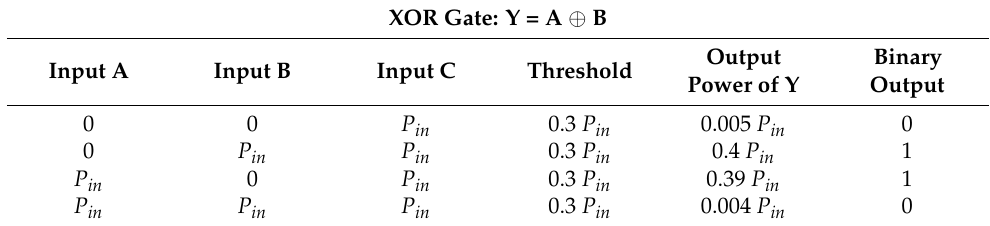
Table 7. Photonic XOR logic gate power and binary output truth table data.